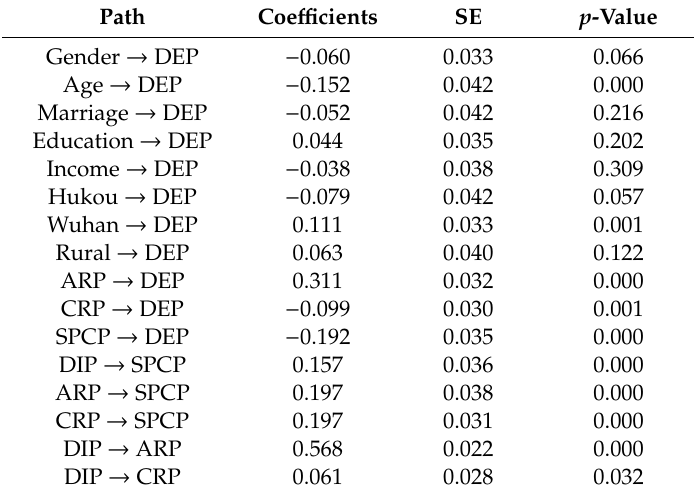
Table 5. Standardized coe ffi cients of the revised structural equation modeling. Path Coe ffi cients SE p -Value Gender → DEP − 0.060 0.033 −